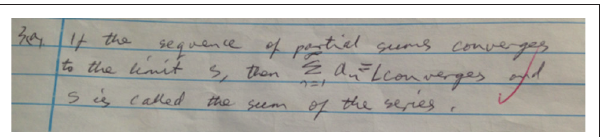
FIG URE 2: Written response of ST15 to task 1a.